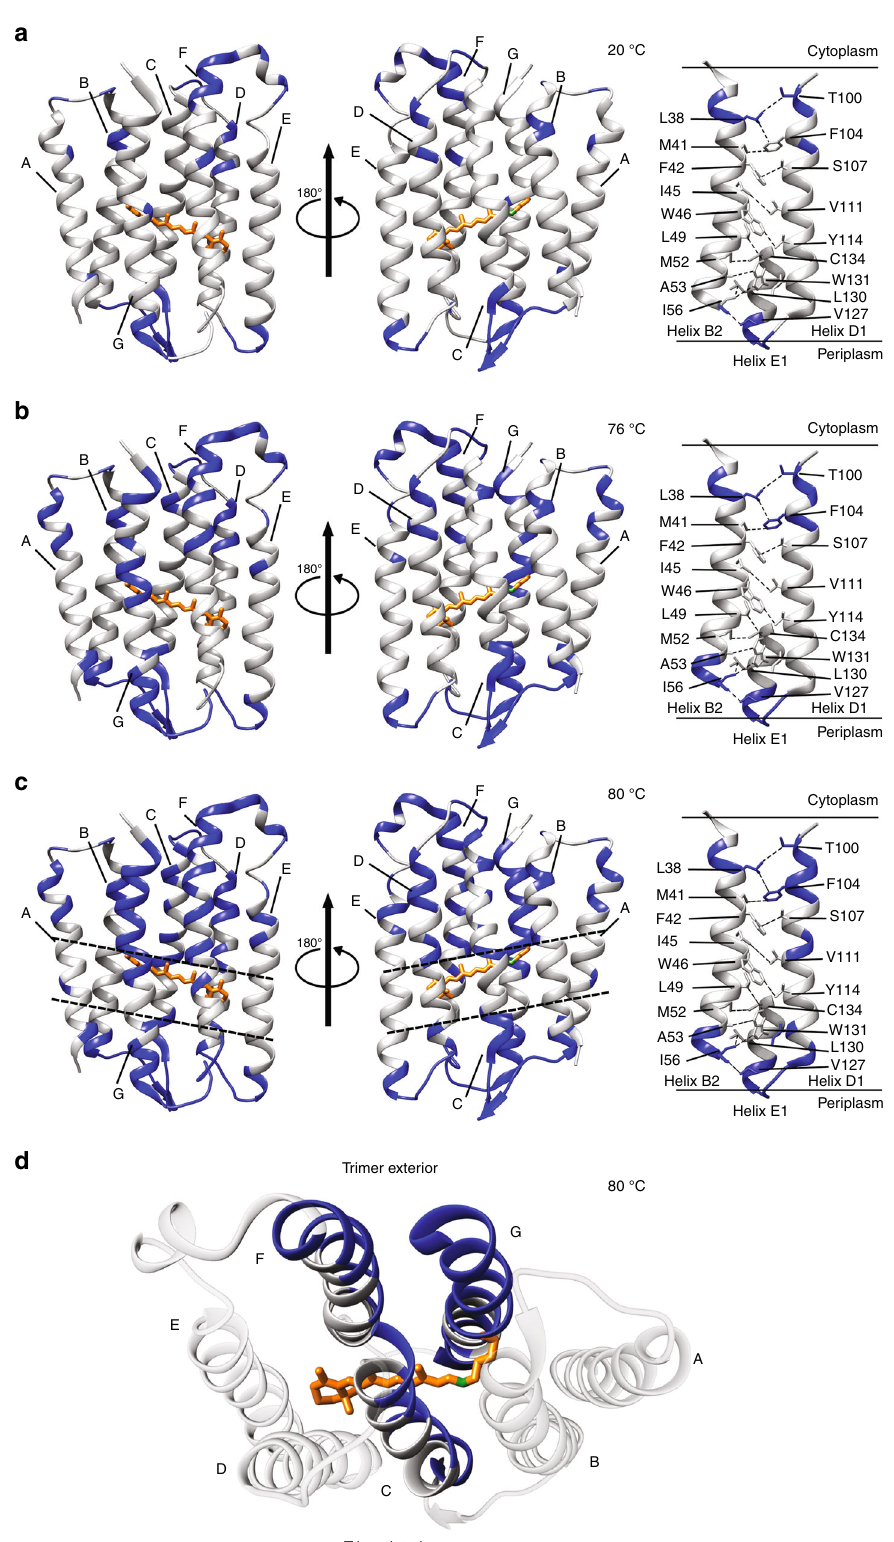
Fig. 6 Structural representation of the H/D exchange patterns. Exchanged residues are mapped on the ASR structural model (PDB 5UK6) 35 after incubation at 20 °C ( a ), 76 °C ( b ), and 80 °C ( c and d ). Left panels in a – c show monomers with cytoplasmic side on top; right panels represent the inter- monomer interface. Exchanged residues are blue, non-exchangeable are gray, retinal is orange. The non-exchangeable slab region is indicated by dashed lines in c . d View from the cytoplasmic side of helices C, F, and G, highlighting the sidedness of their